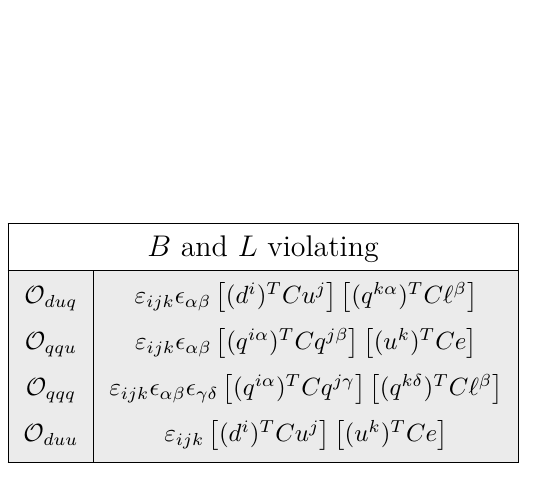
Table 10 . Baryon and lepton number violating four-fermion operators. Generation indices are suppressed and C is the Dirac charge conjugation